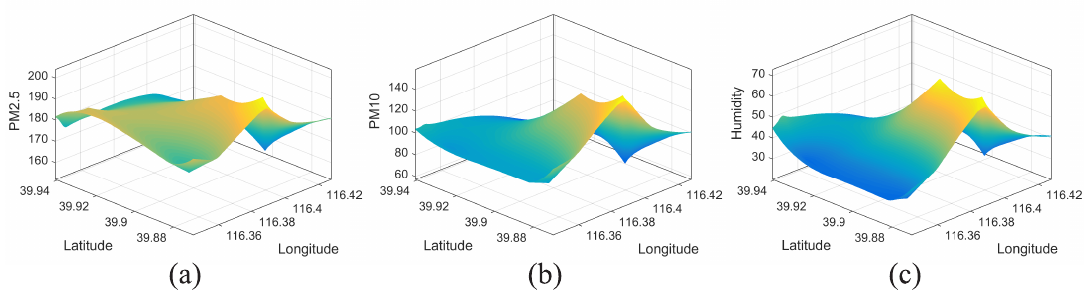
Figure 15. The constructed signals within the red box zones of Figure 12b. ( a ) Signal of PM2.5; ( b ) Signal of PM10; ( c ) Signal of air